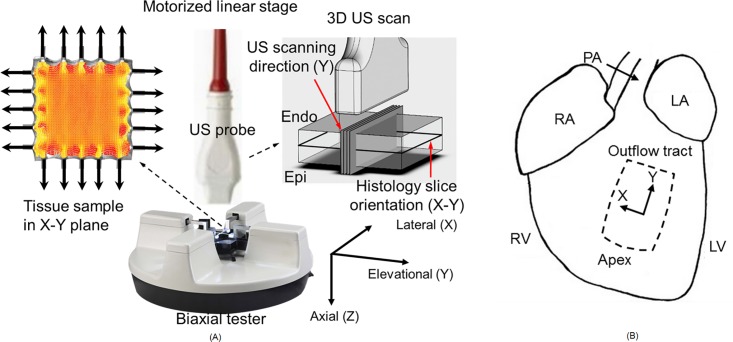
(A) Experimental setup for biaxial testing combined with 3D ultrasound scanning. X: lateral, Y: elevational (scanning), Z: axial (ultrasound propagation) direction of the ultrasound transducer. Note that the 3D speckle tracking and the displacement/strain estimation follow this coordinate. (B) The excised section of right ventricular free wall (RVFW) for biaxial testing. X: cross-preferred (circumferential) direction; Y: apex-to-outflow-tract (longitudinal) direction. Note that the X and Y in ultrasound transducer coordinate and the RVFW sample coordinate match respectively.